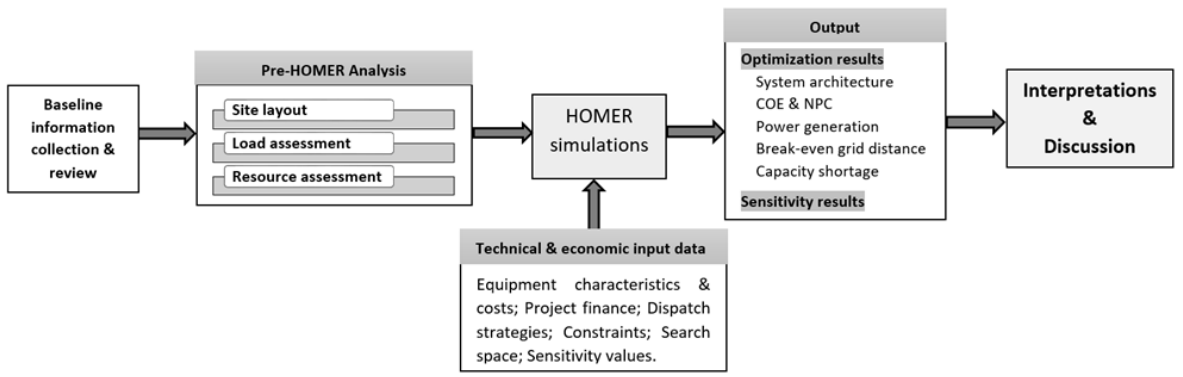
Figure 2. Block diagram of research methodology.